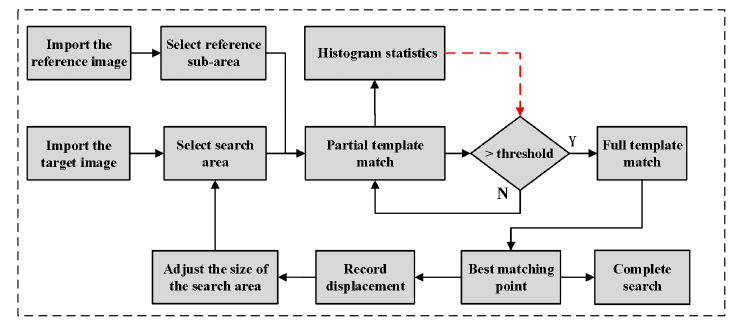
Figure 2. Overall algorithm flow